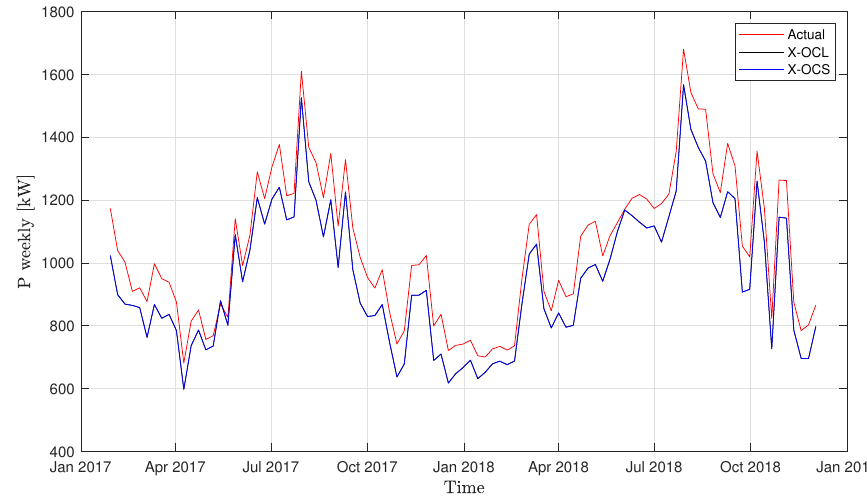
Figure 10. Weekly power consumption time series: comparison bewteen actual recorded data (red), the lower bound R-OCL (black) and the consumption associated with X-OCS